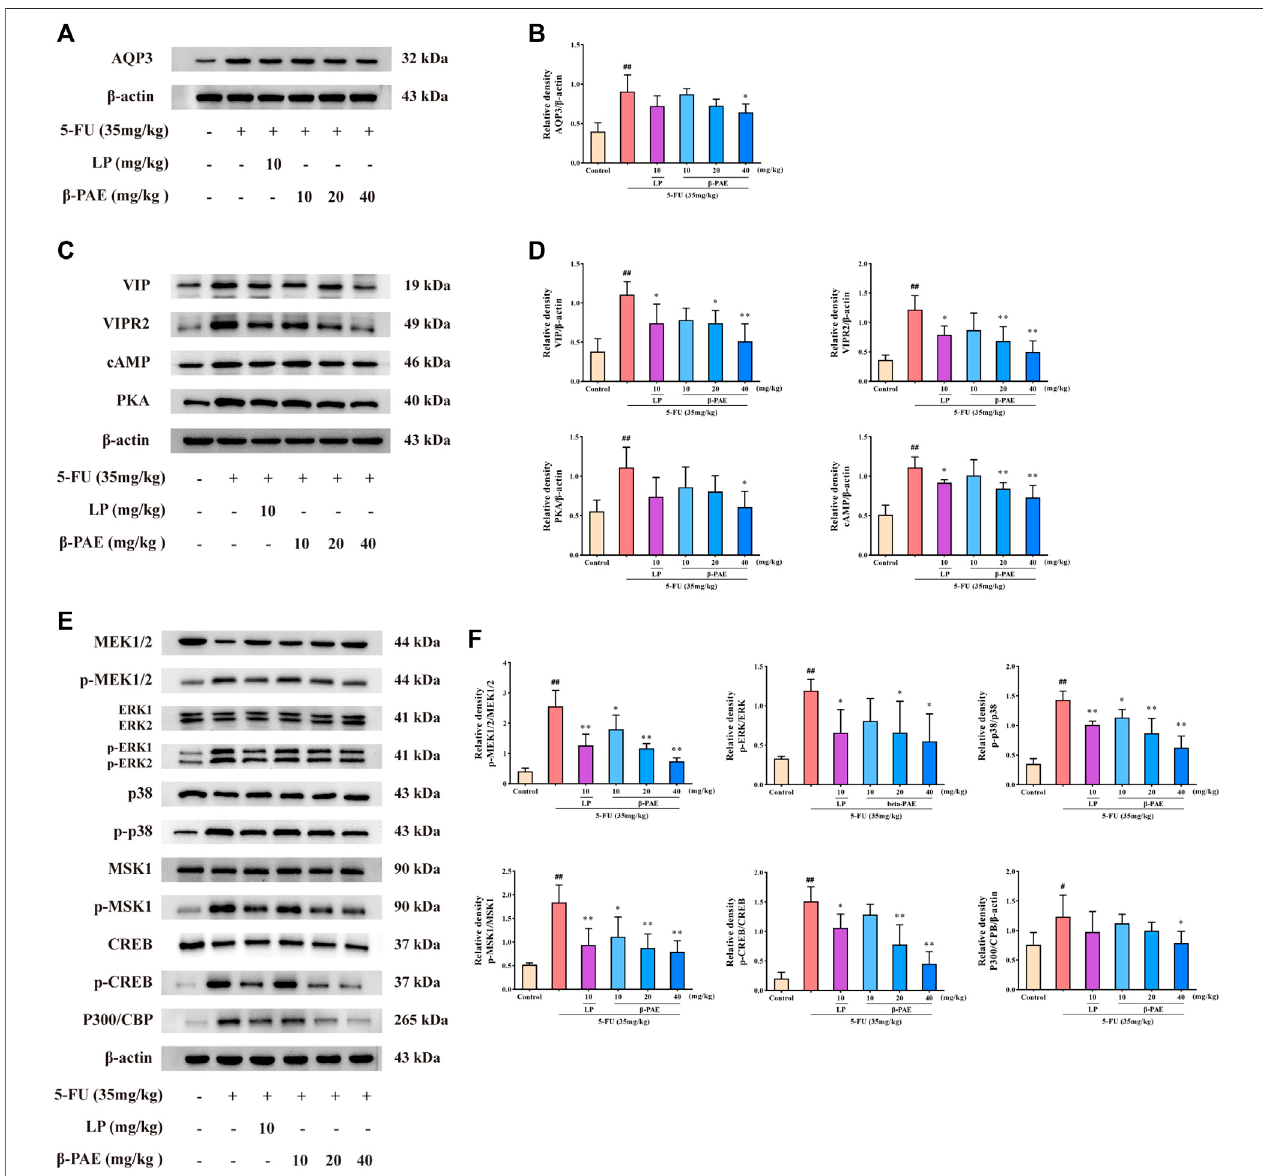
FIGURE5| Effectsof β -PAEonAQP3expressionandcAMP/PKA/CREBsignalingpathway-relatedproteins. (A,B) AQP3expression; (C,D) VIP,VIPR2,cAMPand PKAexpression; (E,F) MEK1/2,p-MEK1/2, ERK,p-ERK, p-p38,p38, MSK1,p-MSK1,CREB,p-CREB,andP300/CBP expression. Dataareshownasmean ± SD( n (cid:2) 3). # p < 0.05, ## p < 0.01 versus control group; * p < 0.05, ** p < 0.01 versus 5-FU